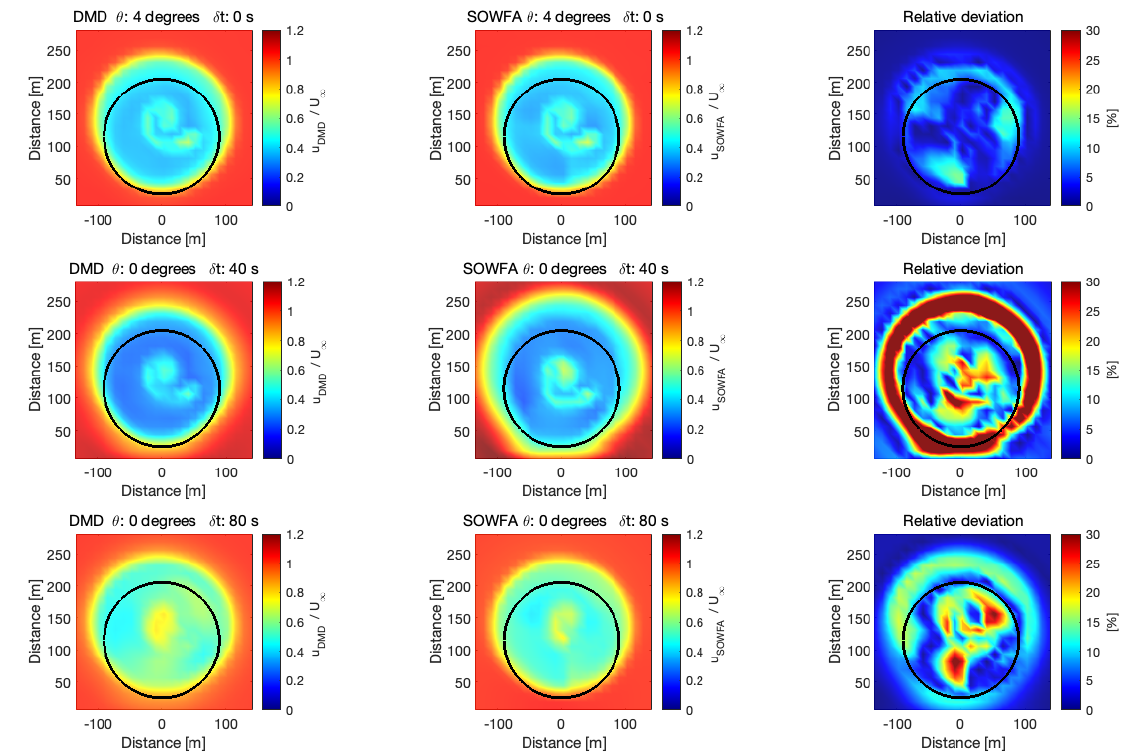
Figure 5. Comparison of flow field reconstruction using reduced linear model ( left ), data from SOWFA ( middle ) and relative deviations at downstream rotor plane ( right ) for different time instants. First row of snapshots corresponds to simulation instant of 16 min and 30 s represented in Figure 4. Higher deviations are noticeable when the travelling wake hits the downstream rotor, illustrated by the middle snapshot. Reconstruction obtained using validation data set. Table 1. Models validation results using IODMD u algorithm, where u is the streamwise velocity component. First column has the data chosen for the states. Second column has the fit criteria VAF (the second turbine generator power is the most relevant, hence acts as a primary decision criteria). Third column has the number of states of the model. Fourth column the fit of the upstream turbine generator power for the chosen model. Fifth and sixth columns present the average NRMSE for identification and validation